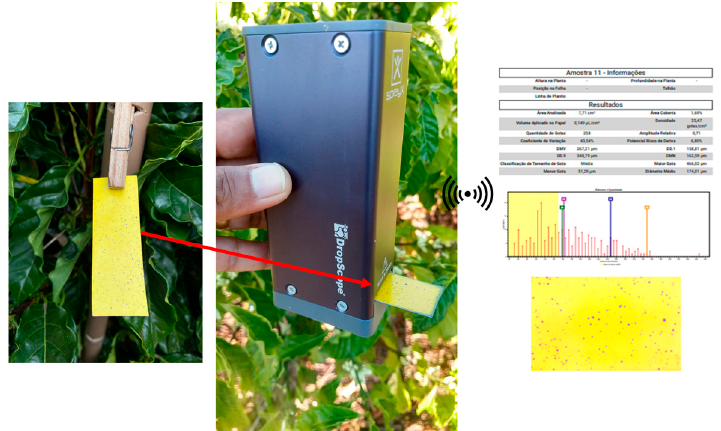
Figure 5. Wireless DropletScope ® System.